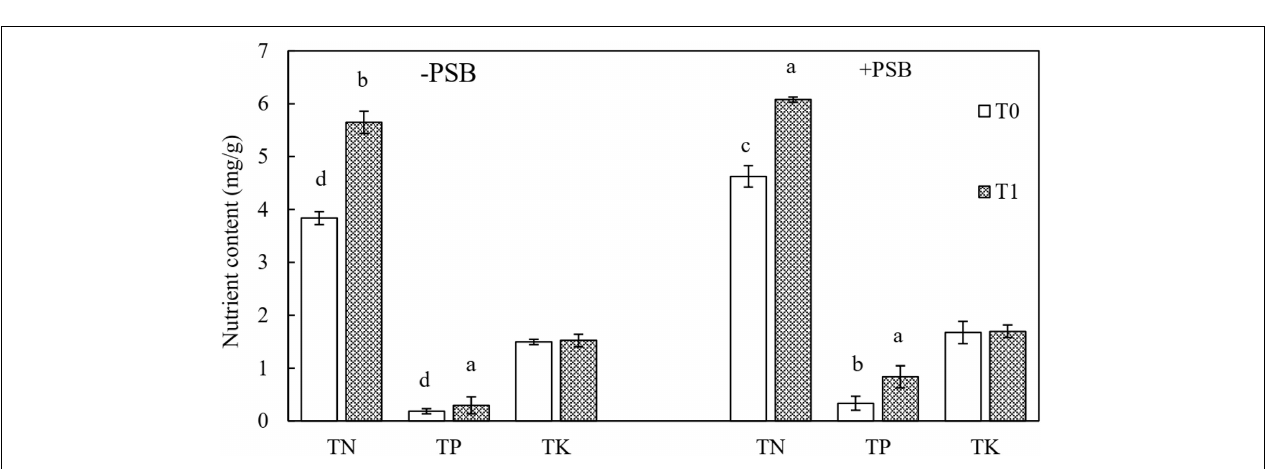
FIGURE 2 | Effects of rock phosphate (RP) and phosphate-solubilizing bacteria (PSB) on total N (TN), total P (TP), and total K (TK) accumulation (mg/g) in peanut leaves. Treatments: T0, without RP; T1, with RP; − PSB, without PSB; +PSB, with PSB. Values are the means of three replicates. Error bars represent ± standard deviation. Values sharing a common letter within the column are not significant at P <